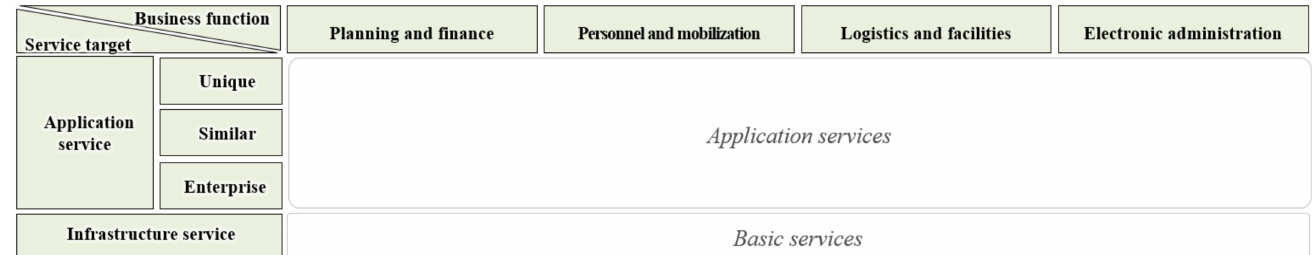
Figure 2. Military service framework (MSF) structure.